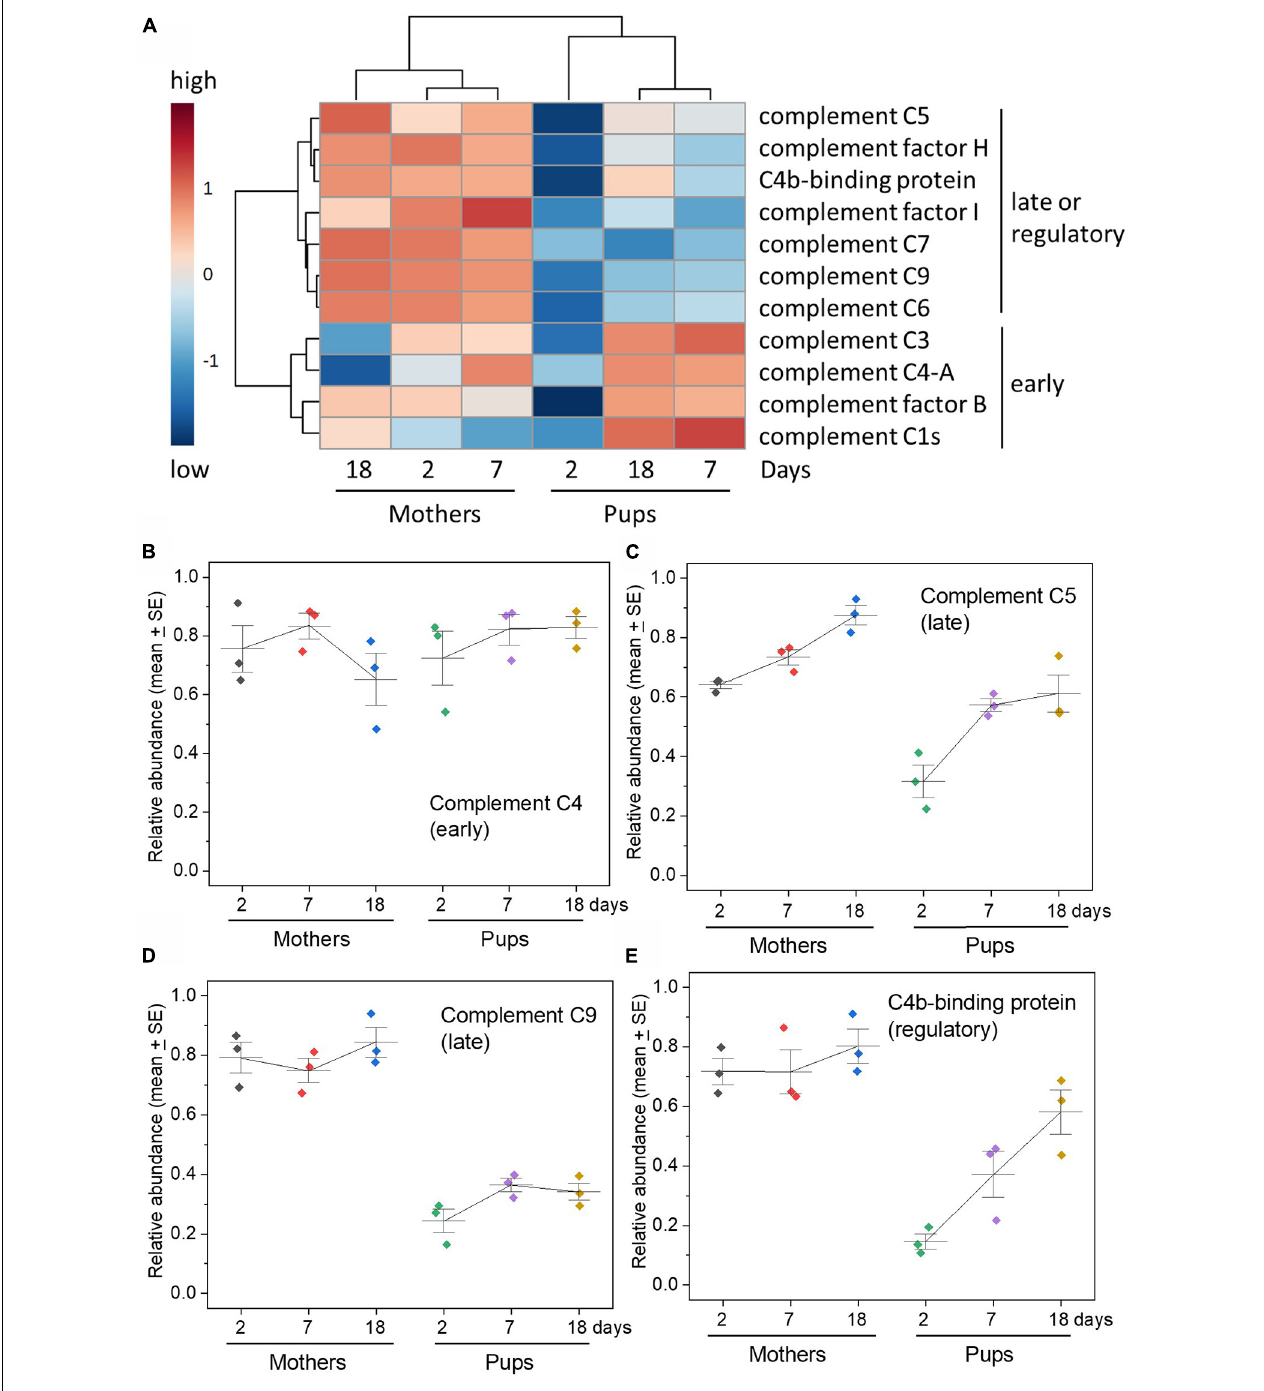
FIGURE 3 | Complement pathways components—disparity between early versus late components of the pathways in relative abundance. (A) Heatmap of relative concentrations of complement pathway components obtained by TMT proteomics along with hierarchical clustering. Note the clear separation between mother and pup sera on all days indicated also by the cluster dendrogram above the heatmap columns. The clustering dendrogram to the left shows the clear bifurcation in abundance and change in the early activation and amplification components (C3, C4, factor B, C1) versus the late, lytic effector, inflammatory components, and control/inhibitory factors (C5, factor H, factor I, C7, C9, C6). (B–E) Changes in selected complement components to illustrate the difference between early and late components and also control/regulatory proteins. C4 is part of the amplification stage after initiation either by antigen:antibody complexes or the lectin pathway; C5 follows C3 activation and binds to a target cell upon which the membrane attack complex builds, which involves C9; C4b-binding protein is a complement control protein that inhibits activities of C4 and also C3. See Supplementary Figure 3 for graphs for all complement proteins detected. Relative abundance values are expressed in arbitrary